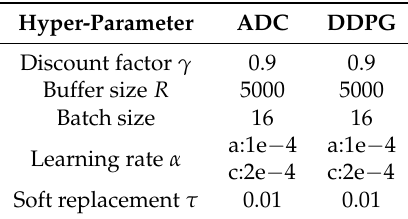
Figure 7. ADC and DDPG’s performance on obstacle avoidance task. The x-axis presents the episodes and y-axis presents the cumulative rewards per episode. The whole process has 3500 episodes and each episode has 500 steps. Table 2.